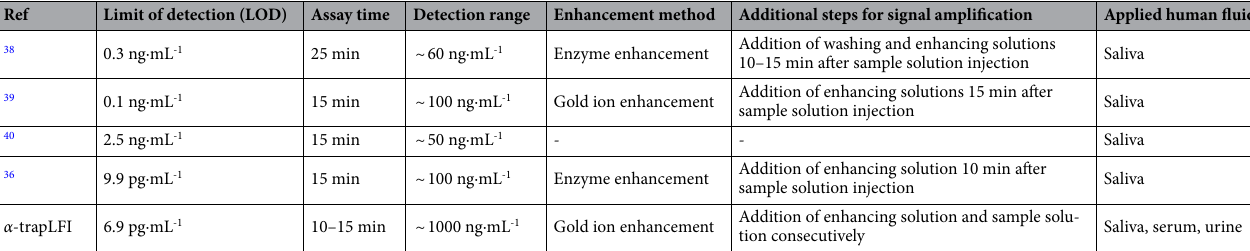
Table 1. Comparison of the specificities of αlpha -trapLFI with previously developed lateral flow immunoassay (LFI).